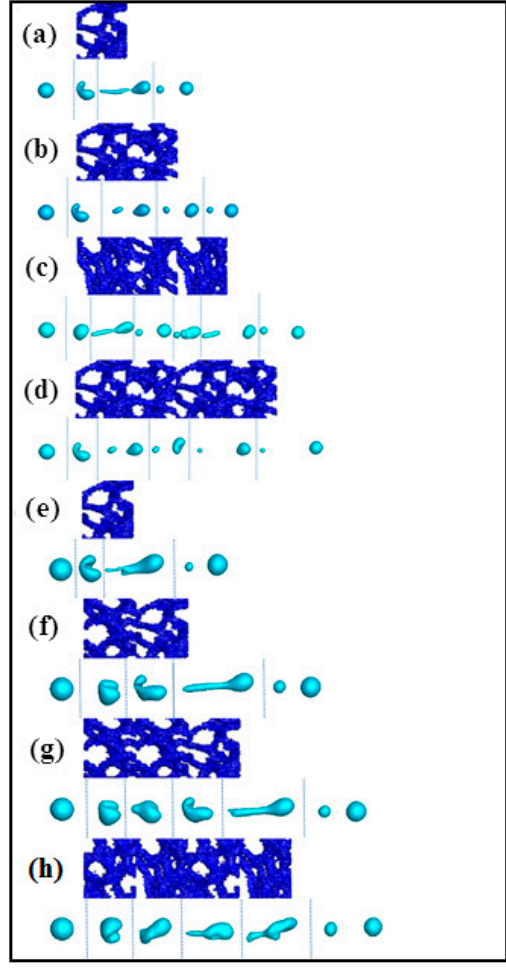
Figure 9. Hydrodynamics of one droplet passing a metal foam with different L d values ( Ca = 0.061): ( a ) L d = 2.44, D d = 1.25; ( b ) L d = 4.88, D d = 1.25; ( c ) L d = 7.32, D d = 1.25; ( d ) L d = 9.76, D d = 1.25; ( e ) L d = 2.44, D d = 1.82; ( f ) L d = 4.88, D d = 1.82; ( g ) L d = 7.32, D d = 1.82; and ( h ) L d = 9.76, D d = 1.82.